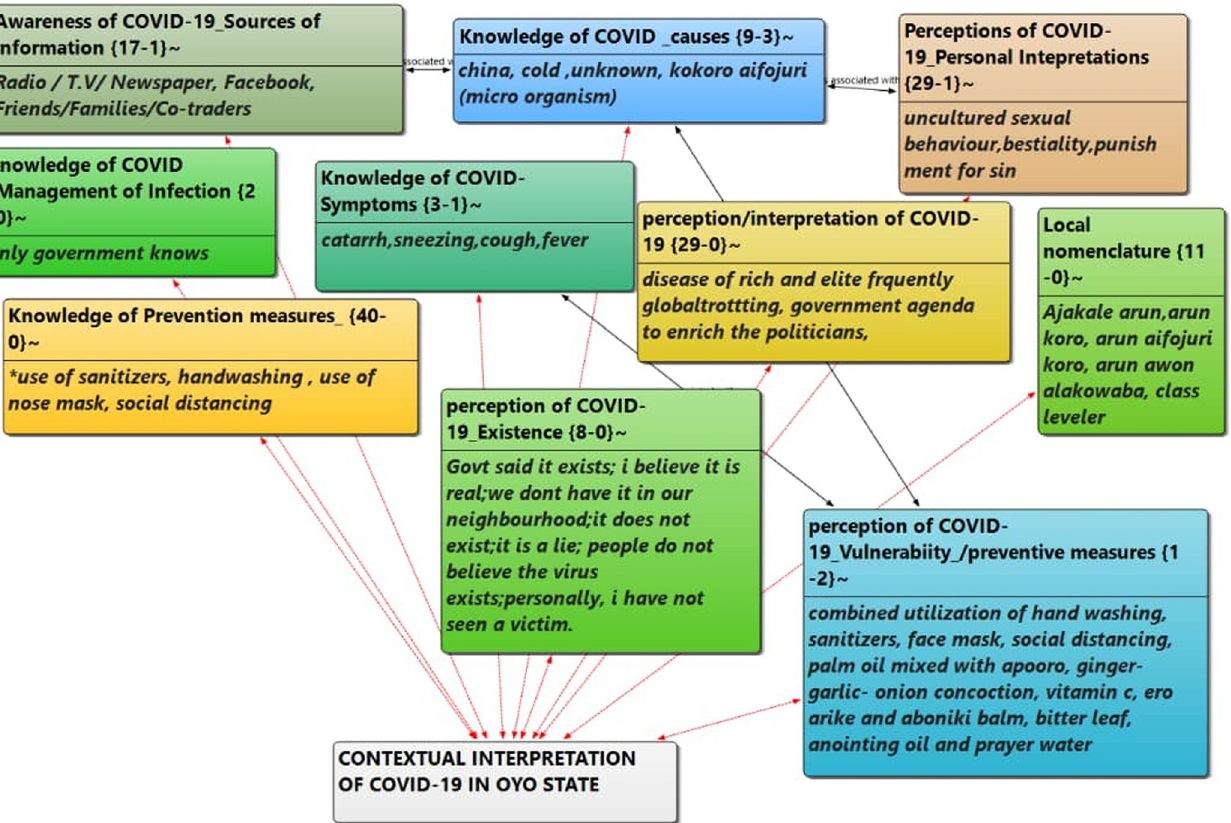
Fig 1. Network analysis of contextual interpretation of COVID-19 among respondents.